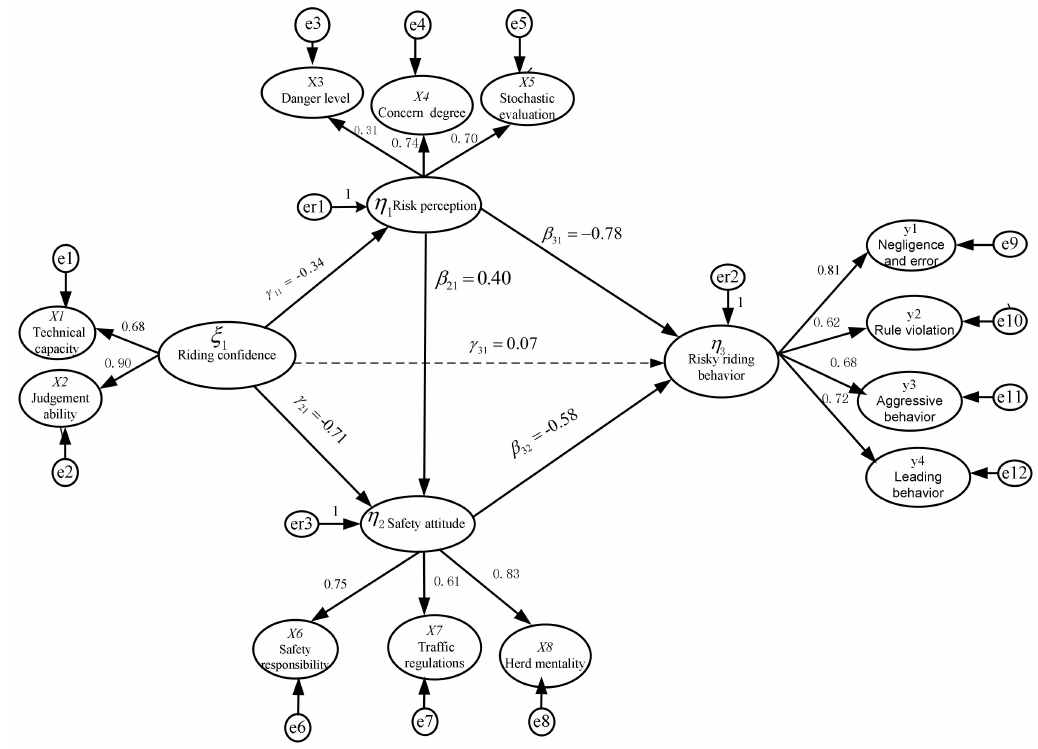
Figure 2. Preliminary fit results of the theoretical